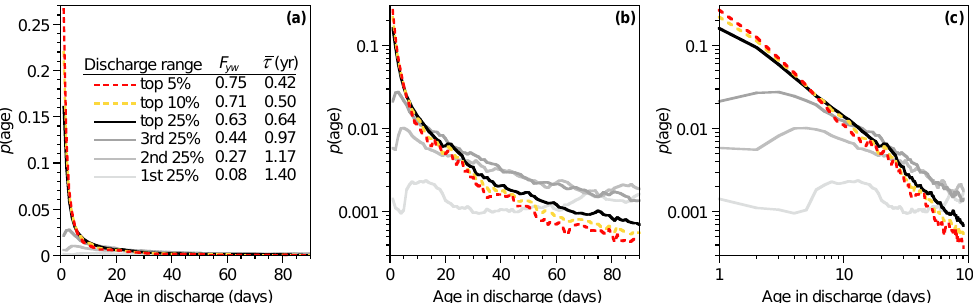
Figure 6. Marginal (time-averaged) transit-time distributions (TTDs) for selected ranges of daily discharges in the two-box model, with the reference parameter set and Smith River (Mediterranean climate) precipitation forcing, on linear (a) , log-linear (b) , and double-log (c) axes. The TTD becomes increasingly skewed at higher discharges (a), with a marked increase in the young water fraction F yw and decrease in the mean water age τ . For the upper half of all discharges, the age distribution is upward-curving on log-linear axes (b) , implying that it is more skewed than exponential. Discharges in the top 25% and above have approximately power-law age distributions, plotting as nearly straight lines on double-log axes (c)